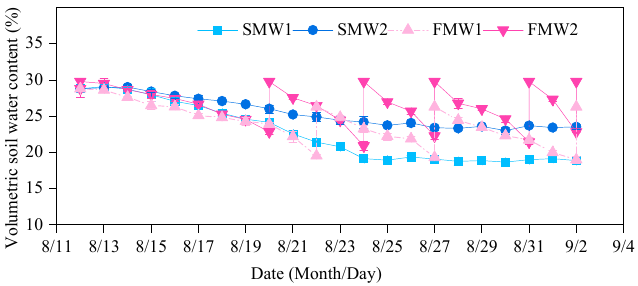
Figure 2. Changes in volumetric soil water content. Values are the mean ± SD (n = 3). Table 1. Soil moisture parameters under different